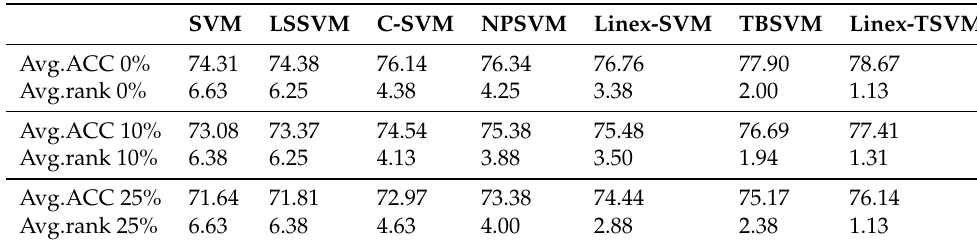
Table 5. Average accuracy and ranks of six algorithms on UCI datasets with 0%,10%,25% Gaussian noise.